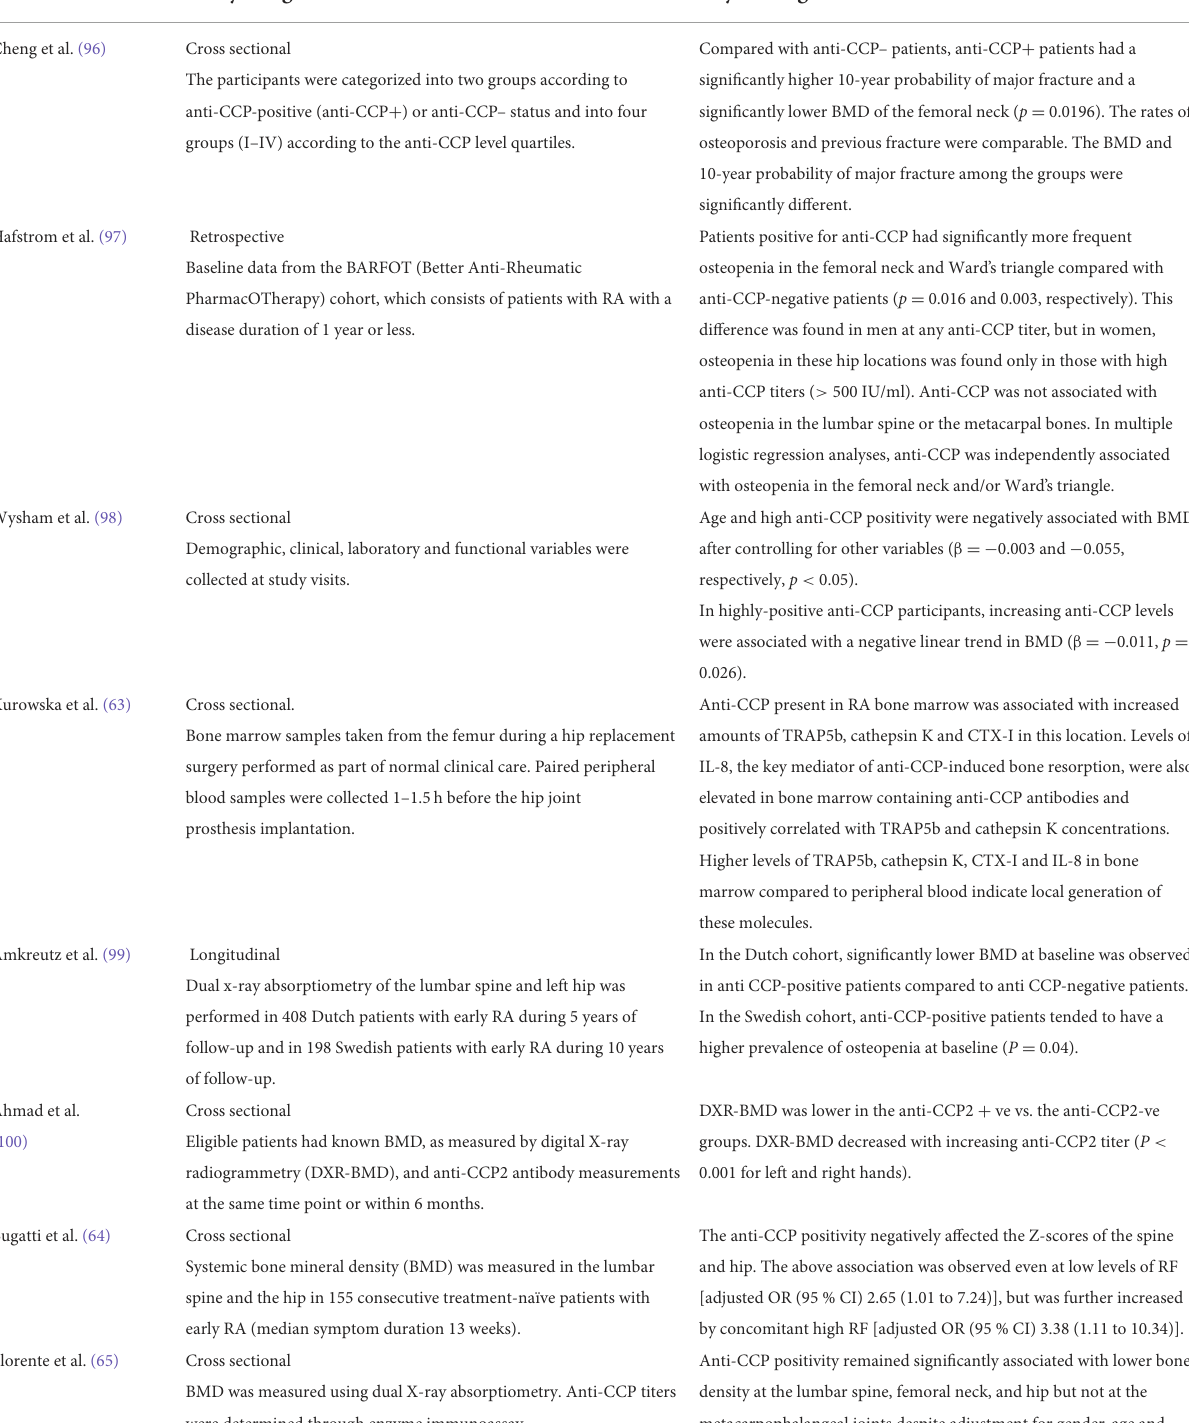
TABLE 3 Recent studies on the association between anti-CCP and bone mineral